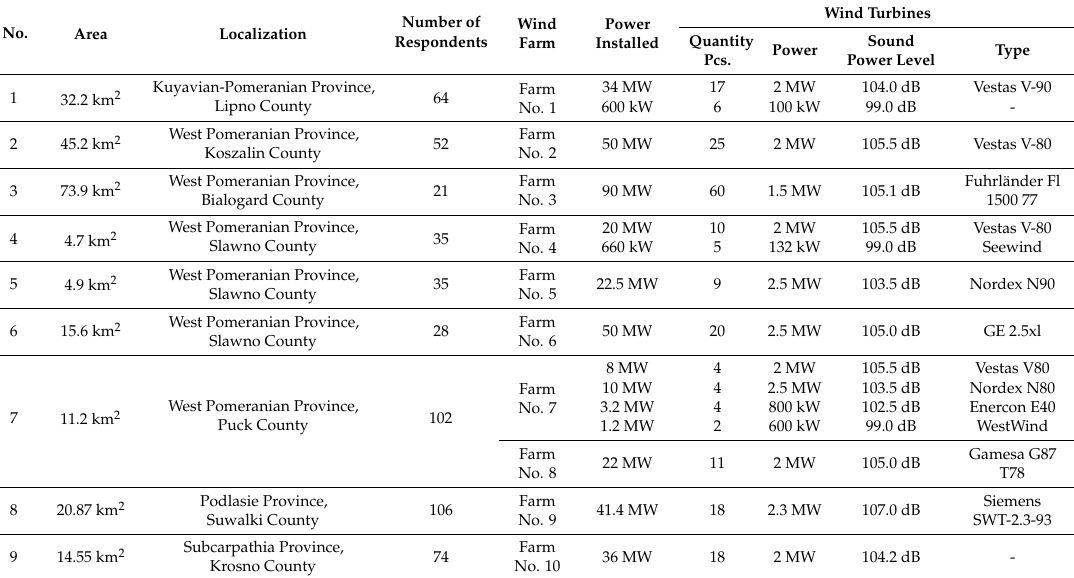
Table 1. Characteristics of investigated